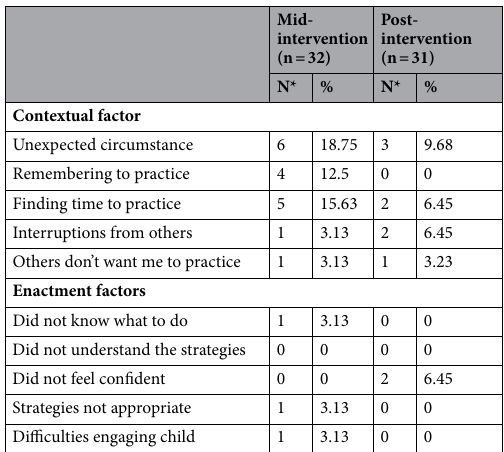
Table 7. Factors impacting adherence to home practices. *Indicated that the statement to be 4 or above (4 = True, 5 = Very true).